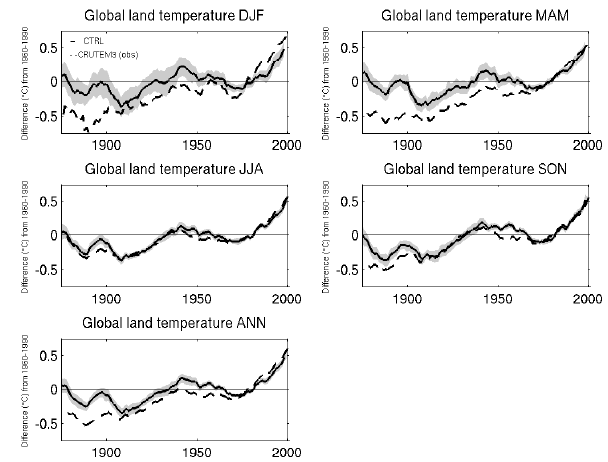
Fig. 2. Simulated (CTRL, solid) and observed (CRUTEM3, dashed) annual and seasonal global land temperature anomalies ( ◦ C), rela- tive to the 1960–1990 mean, shown as 11yr running means. Gray shaded area corresponds to the ± 1 sigma spread of the ensemble